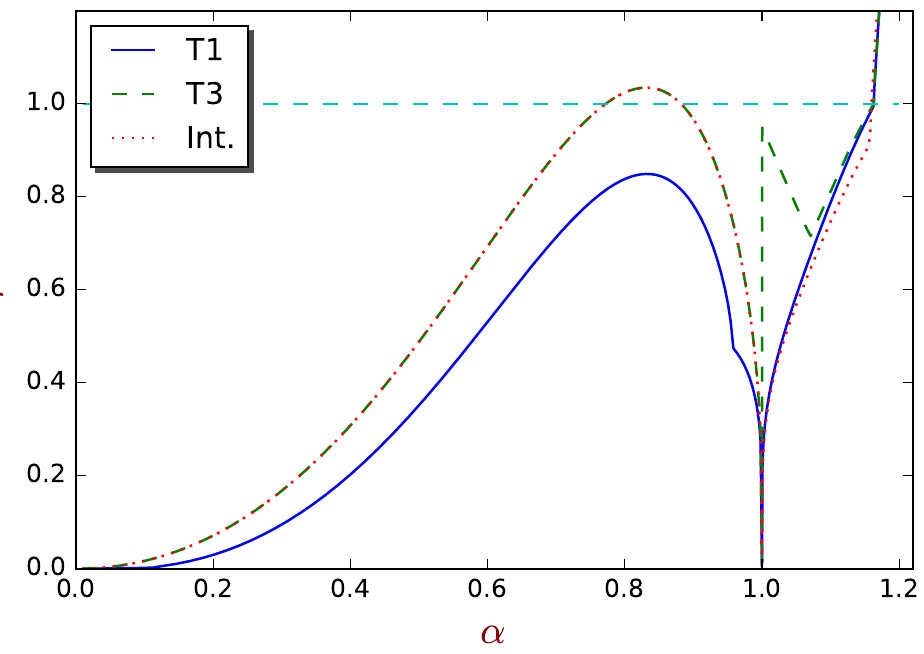
Fig. 7 Spectral radius of the AM7 methods for T1, T3 and interpolation techniques. Note that there exists an interval near 0.8 where the spectral radius of T1 and interpolation techniques is greater than